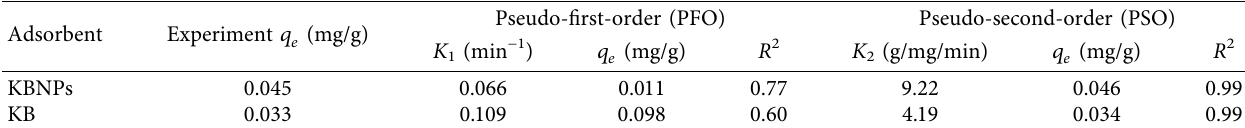
Table 2: Kinetic models’ parameters for adsorption of fluoride onto granules.